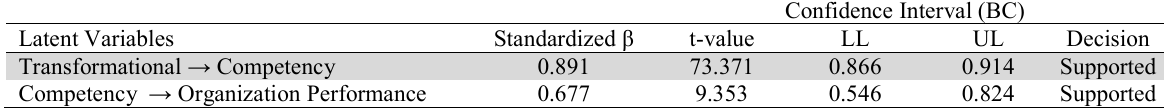
Summary of Mediation Path Coefficient and Relevance Relationship